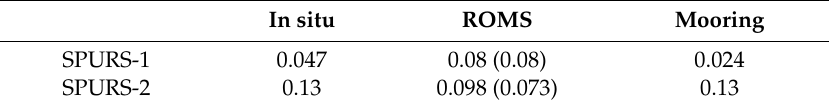
Table 1. Summary of σ 50 values from Figure 5; Figure 9 In situ ROMS